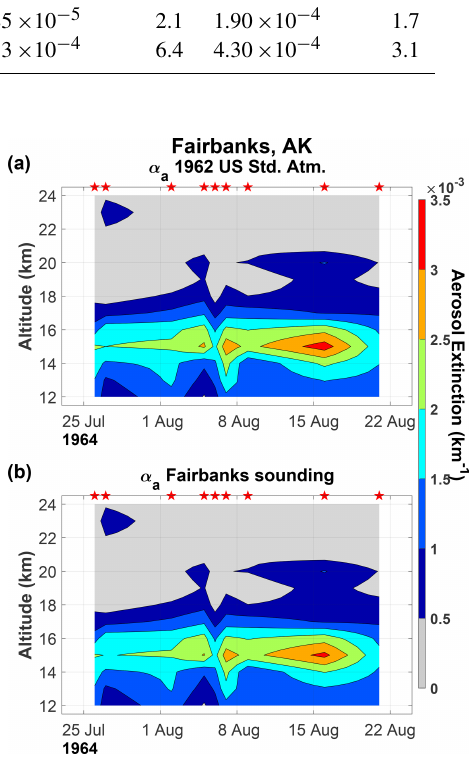
Figure 2. The same as Fig. 1 but for Fairbanks,